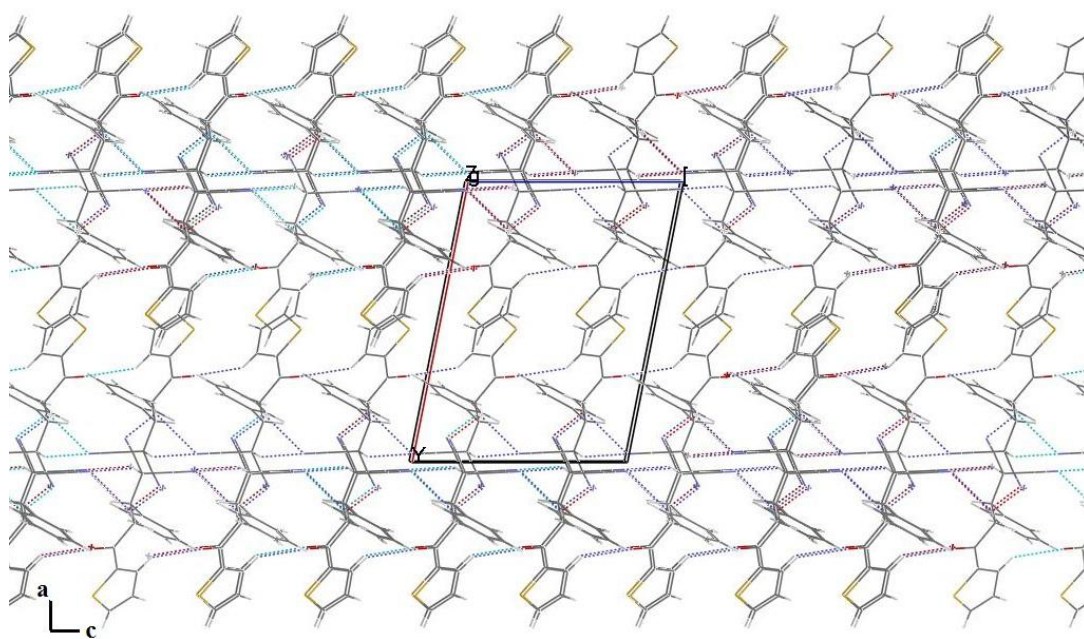
Figure 2. Packing preview of 2 , view along b-axis.